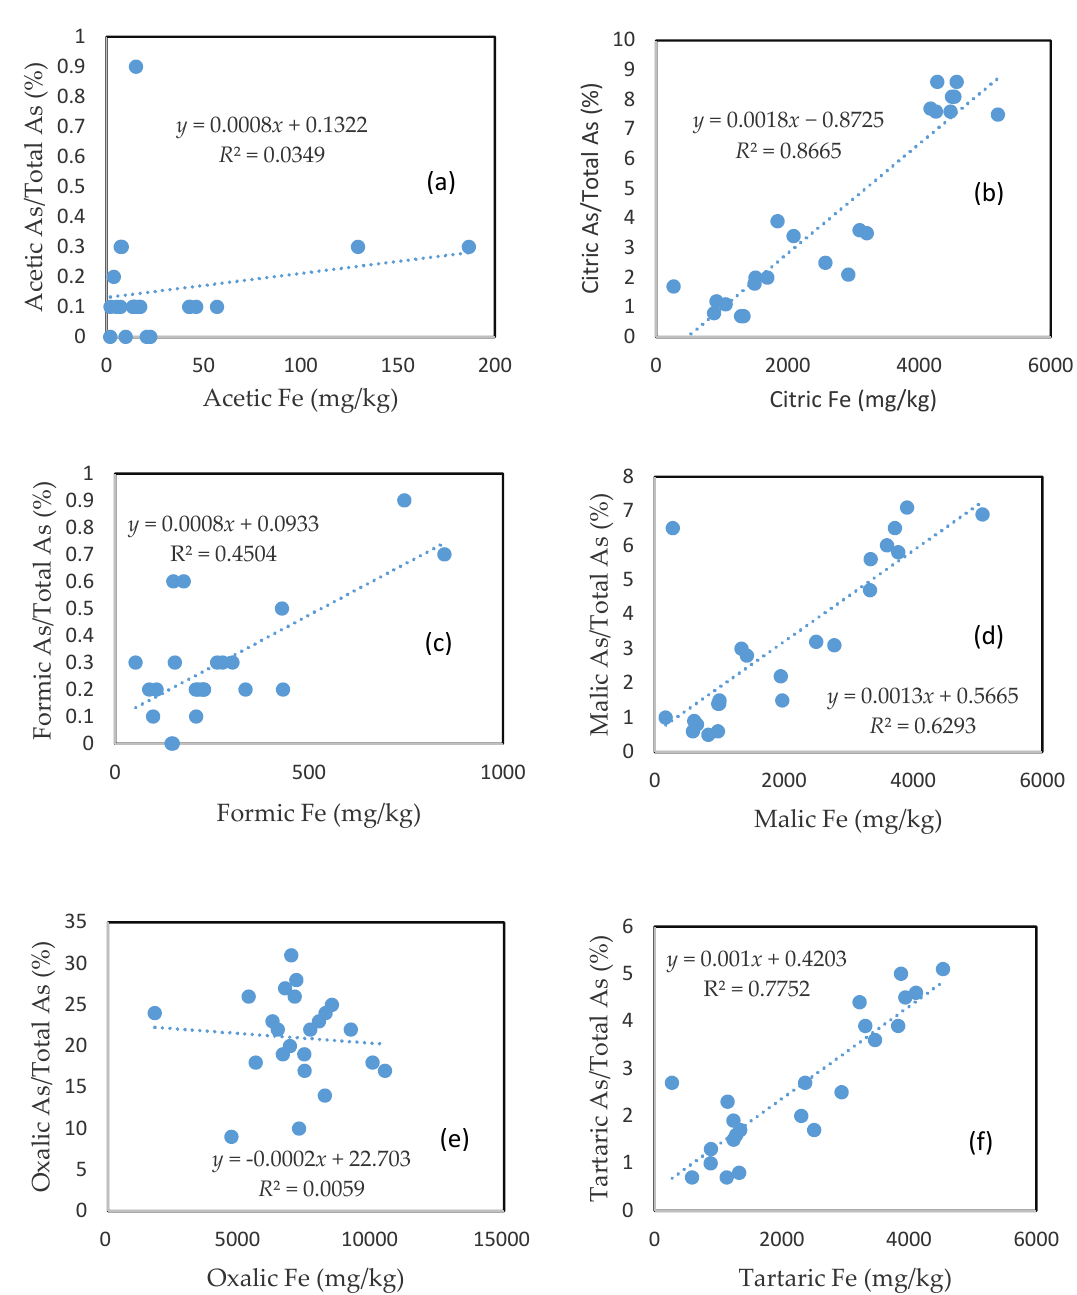
Figure 2. Relationship between the amount of Fe released from the soil and the rate of As mobilization in ( a ) acetic acid, ( b ) citric acid, ( c ) formic acid, ( d ) malic acid, ( e ) oxalic acid, and ( f ) tartaric acid treatments.